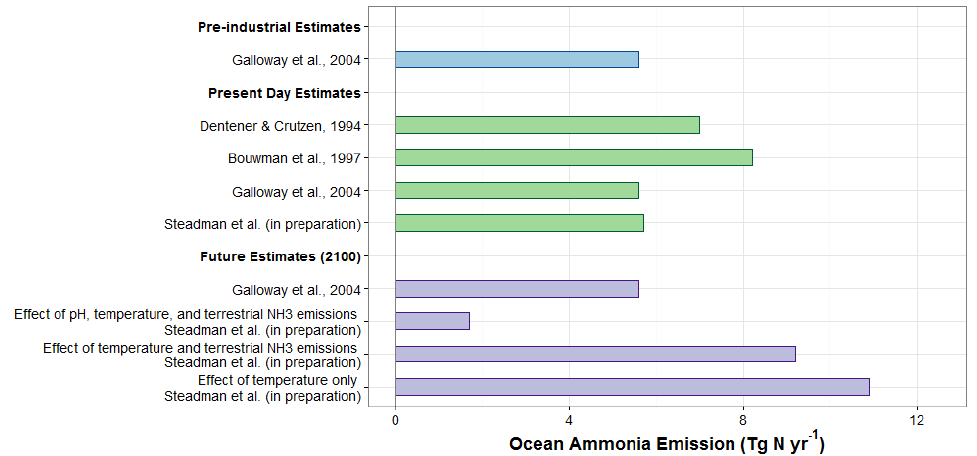
Figure 5. Summary of pre-industrial (blue), present (green), and future (purple, for 2100) estimates of marine ammonia flux from ocean to atmosphere.